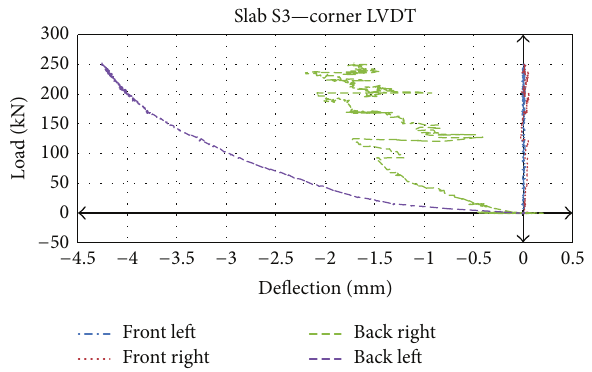
Figure 48: Crack pattern on failure surface of slab